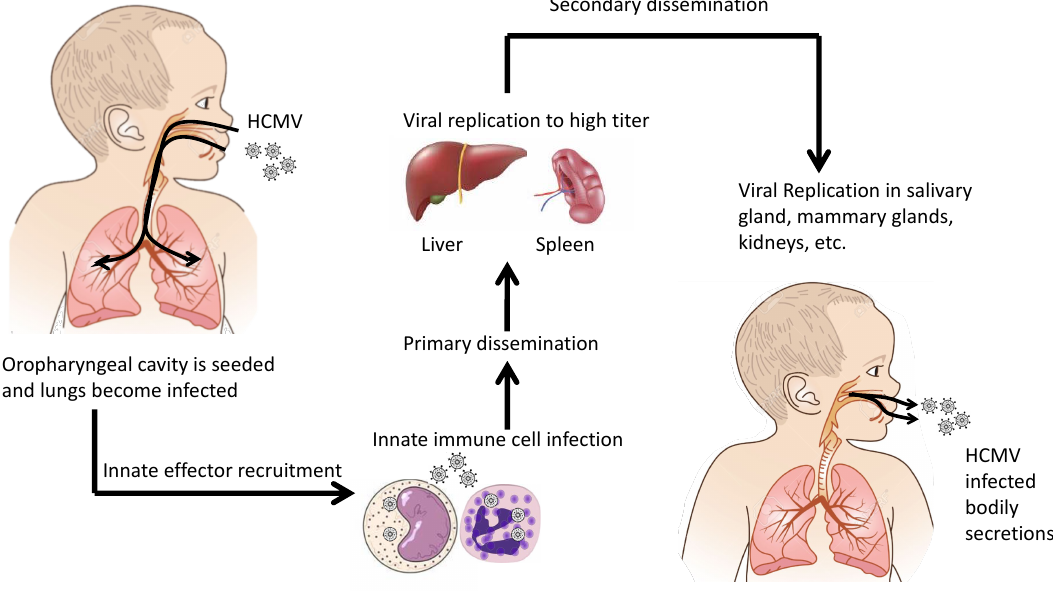
Figure 1. Overview of human cytomegalovirus (HCMV)